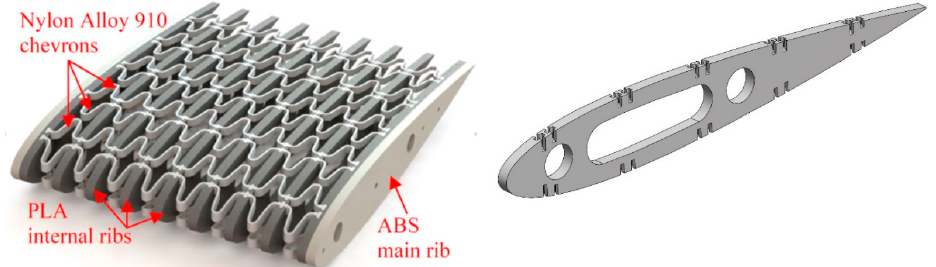
Figure 4. ( left ) The honeycomb substructure, ( right ) internal rib